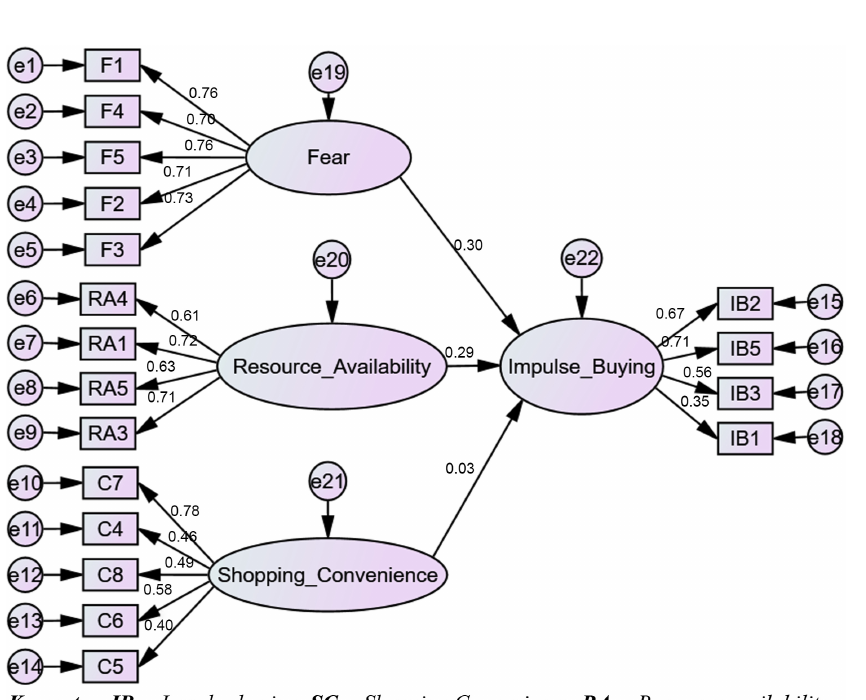
Figure 2. Structural